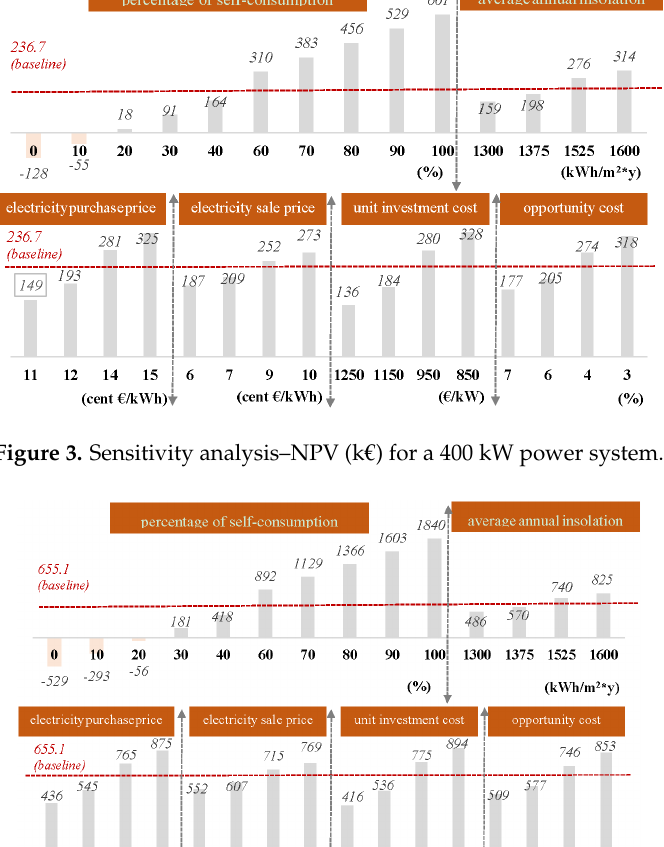
Figure 2. Sensitivity analysis–NPV (k€) for a 200 kW power system. NPV: net present value.